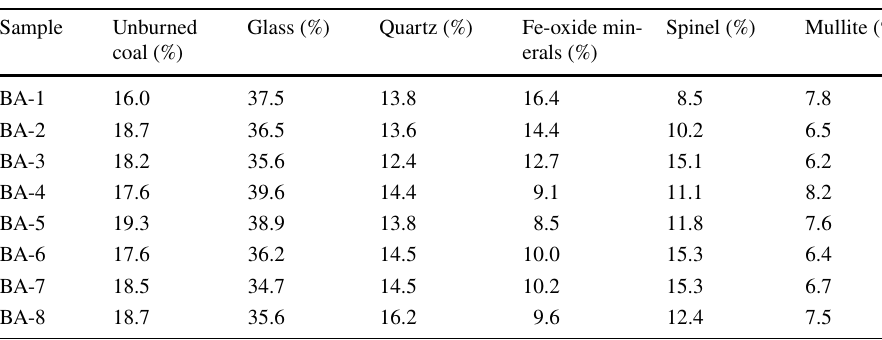
Sample Unburned Glass coal (%)